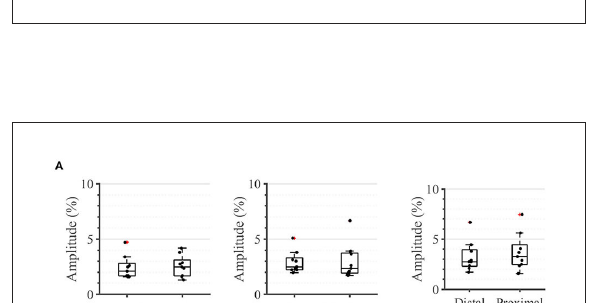
FIGURE4 Task 1–Sensation thresholds (in percent of the maximum stimulation amplitude) for (A) all 12 locations in the arm-shoulder region, (B) the three arm-shoulder segments, and (C) the ventral and dorsal side of the arm-shoulder region. The box plots depict the median value (horizontal line) and the IQR (rectangle) of mean ST data collected from 10 subjects. Red crosses indicate statistical outliers within a single box plot ( n = 10). An asterisk indicates that there is a statistical difference ( p < 0.05, corrected).